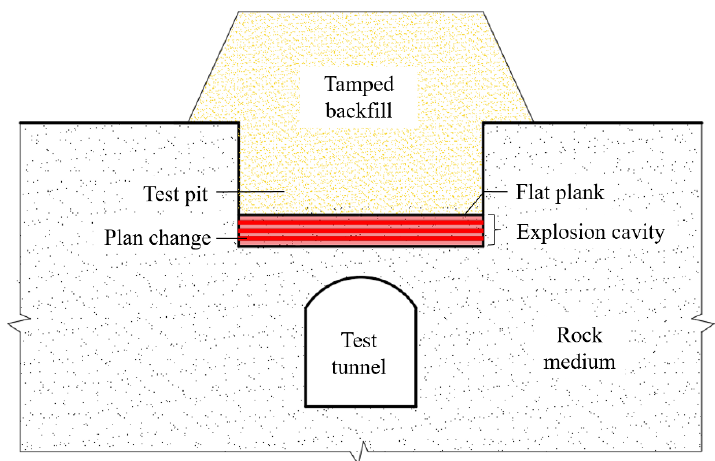
Figure 1. The schematic of the high-pressure plane charge loading test.